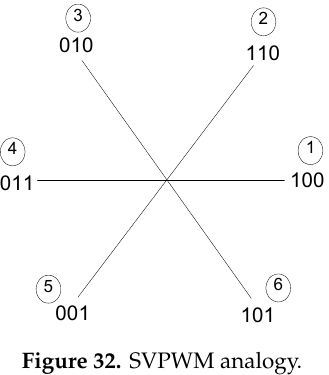
Figure 31. PCB (Printed Circuit Board) layout.